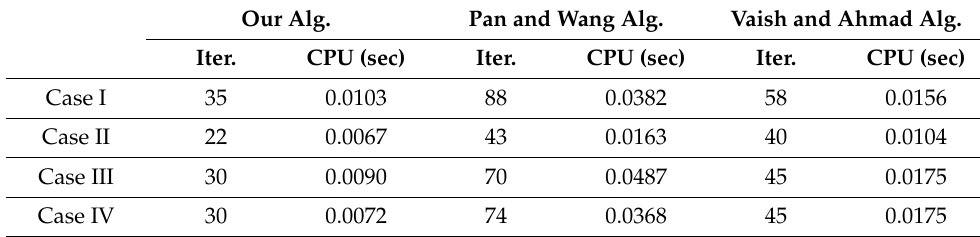
Table 2. Computational results showing the performance of the algorithms for Example 2. Our Alg. Pan and Wang Alg. Vaish and Ahmad Alg.